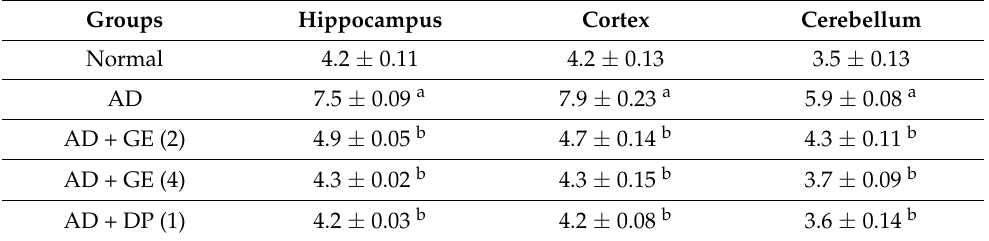
Table 2. Effect of GE on the changes in TBARS levels in brain tissue biomarkers.